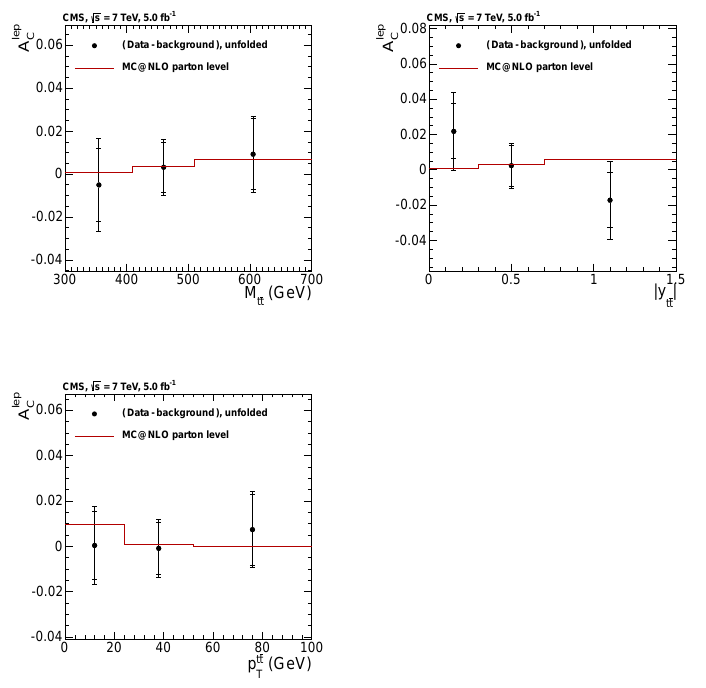
| ( top right ), and p t ¯ t values (points) on m t ¯ t ( top left ), | y t ¯ t T C